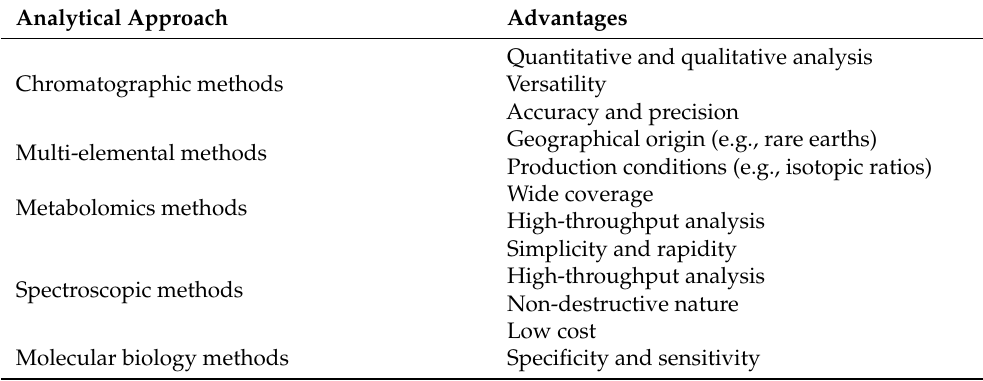
Table 1. Summary of analytical approaches commonly employed in food authenticity and